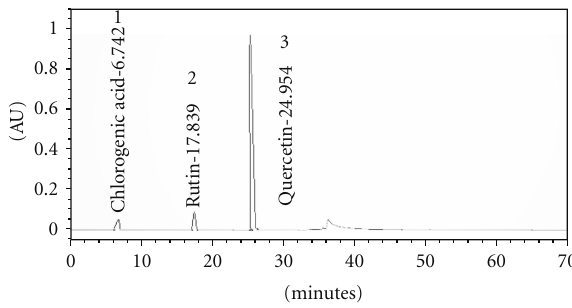
Figure 1: HPLC analysis of Pinus roxburghii Sarg. (Pinaceae) show- ing presence of chlorogenic acid (1), rutin (2) and quercetin (3).